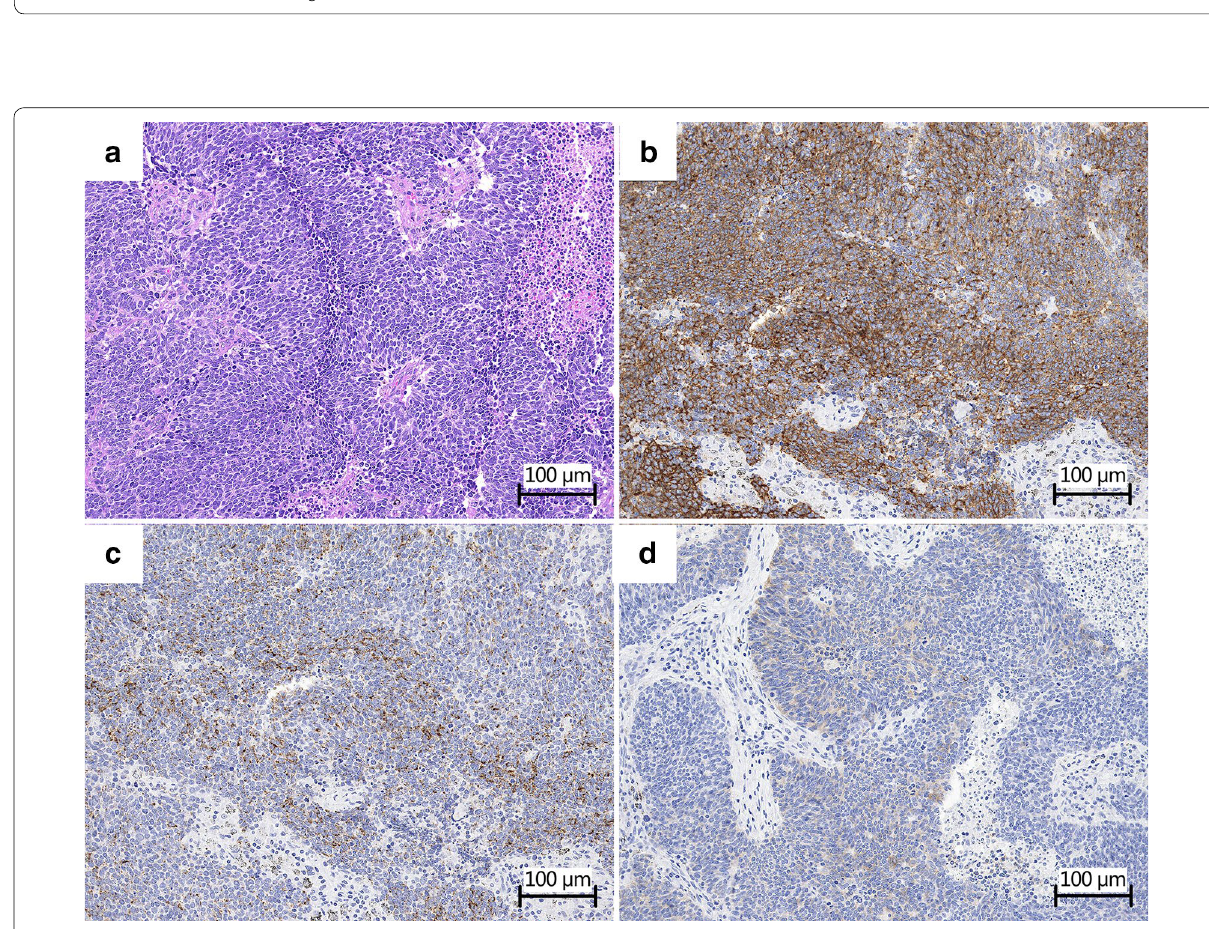
Fig. 2 Pathological and cytological findings in an SCLC patient with LEMS. Specimens were obtained by cervical lymph node biopsy on February 14, 2002. Paraffin-embedded sections were stained with antibody using the polymer method (The Dako Envision ™ FLEX, Dako Japan, Tokyo, Japan) and signal was developed with diaminobenzidine (DAB). Sections were counterstained with hematoxylin. Positive staining for markers in cytoplasm and on cell membrane was indicated in brown . a There are dense sheets of small cells with nuclear molding and necrosis (hematoxylin–eosin stain- ing). b CD56 was diffusely and strongly positive on cell membrane. c Chromogranin A was diffusely and moderately expressed in cytoplasm. d Synaptophysin was focally and weakly expressed in